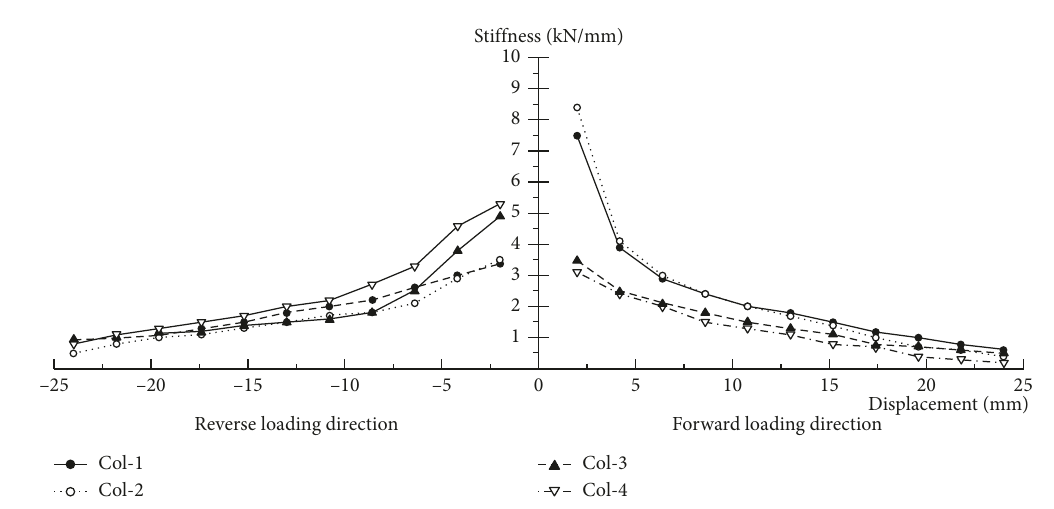
Figure 9: Stiffness degradation curve.